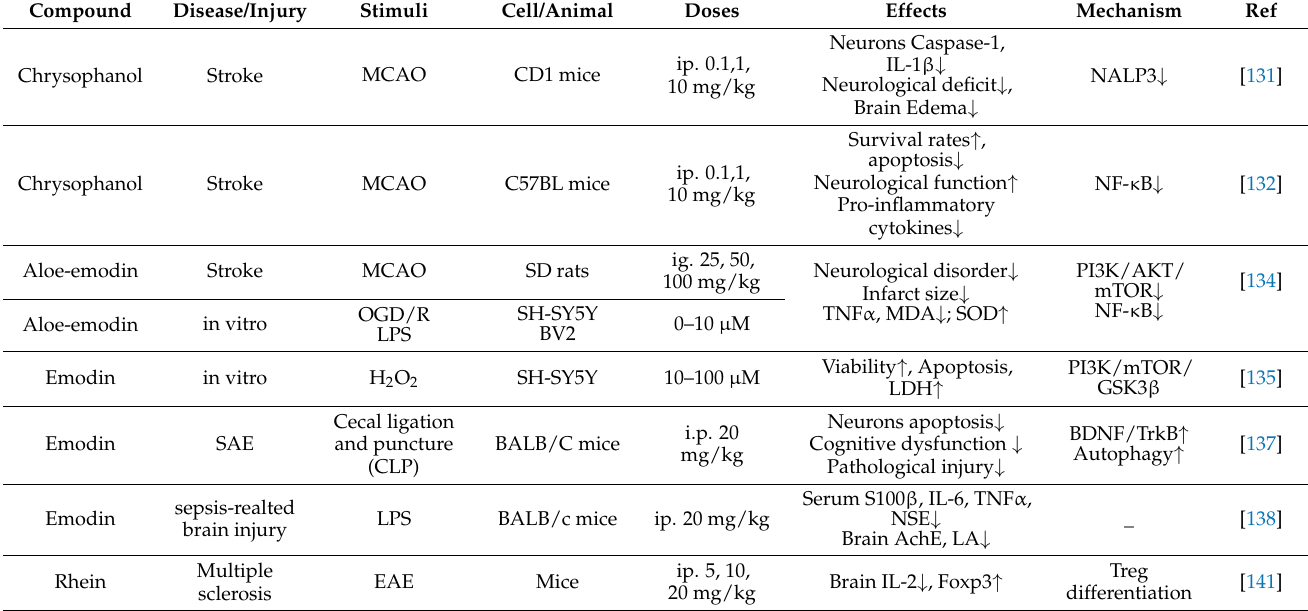
Table 6. Effects and mechanism of AQs on cerebral vascular diseases and central nervous